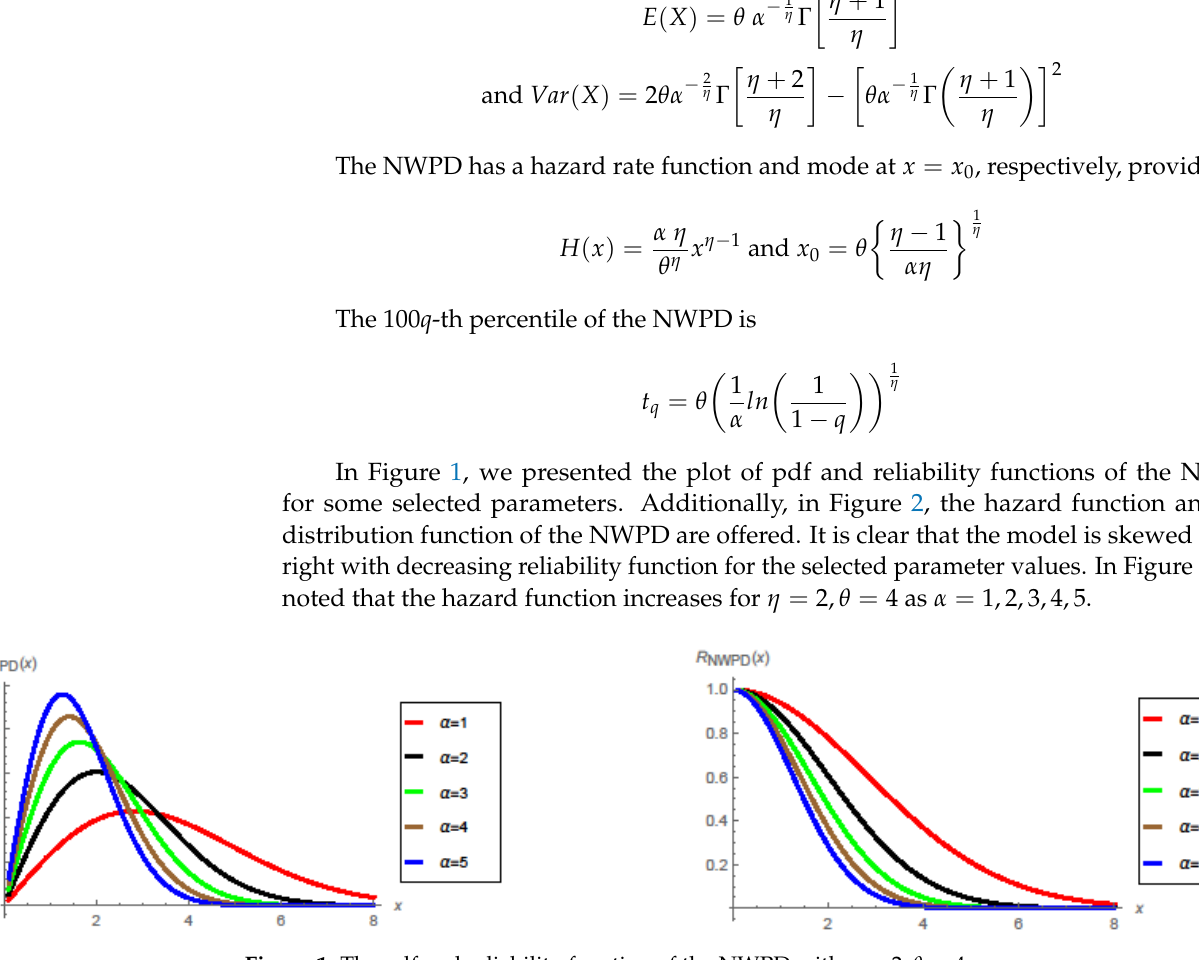
Figure 1. The pdf and reliability function of the NWPD with 2, 4  = = .